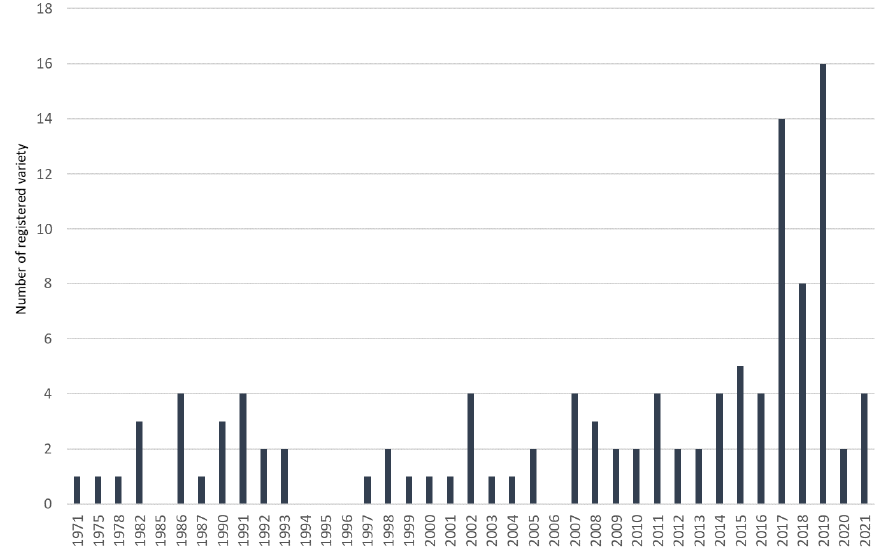
Figure 11. Number of field bean varieties according to registration year from the national variety lists of the EU member states [47–64].